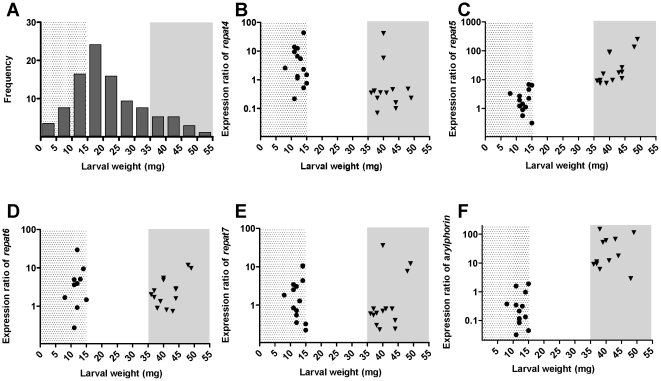
Correlation of resistance and gene expression in the Xen-RU insects.(A) Larval weight distribution (5 mg-intervals) after feeding for 6 days of second-instar larvae on artificial diet containing 25 µg/cm2 of Xentari™ product. Two groups of insects were used in further analyses. The S-group (dotted background) included small larvae (susceptible) with a larval weight below 15 mg; the B-group (grey background) included big larva (resistant) with a larval weight above 35 mg. The relative expression, as determined by qRT-PCR, of the genes studied in the two groups of selected larvae is shown in panels B (repat4), C (repat5), D (repat6), E (repat7), and F (arylphorin). The expression ratio was calculated in relation to the FRA colony using different pools of larvae of similar larval instar and weight for the analysis of the relative expression in the S- or B-group. Results from the correlation analysis between the different pairs are summarized in table 3.